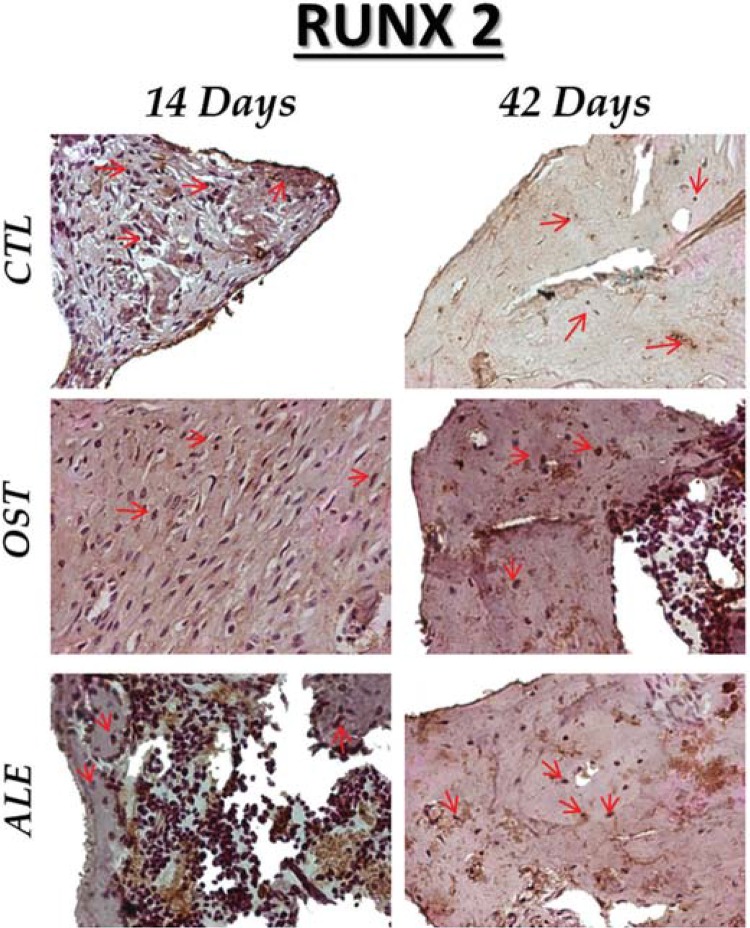
RUNX 2 immunostaining at 14 days for the experimental groups (CTL: moderate; OST: light; ALE: moderate). At 42 days (CTL: light; OST: light; ALE: light). Immunolabeling indicated by red arrows. (Original, 40x)